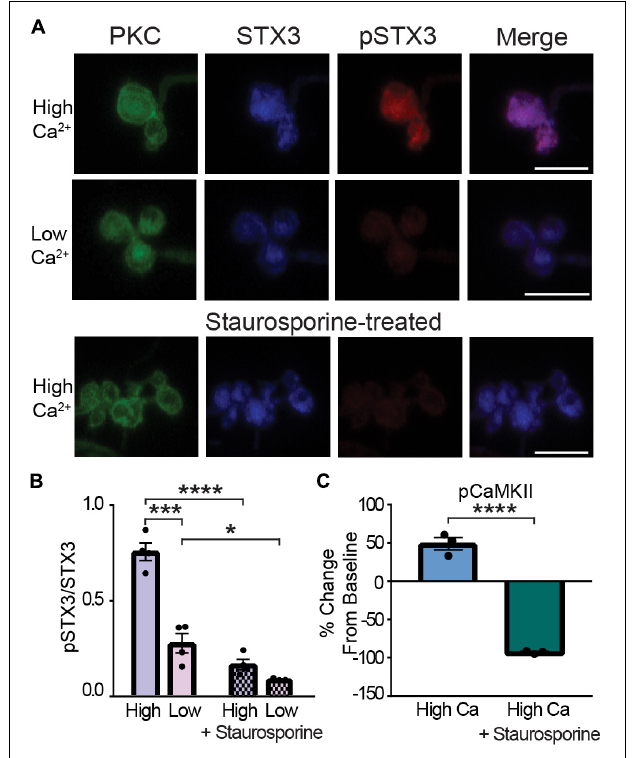
FIGURE 6 | Kinase inhibition prevents the Ca 2 + -dependent phosphorylation of STX3B at T14 in rod bipolar cell synaptic terminals. (A) Confocal images of synaptic terminals of isolated rod bipolar cells, identified by their characteristic morphology and PKC immunoreactivity (green), demonstrate an increase in pSTX3 immunoreactivity (red) under conditions of elevated intraterminal Ca 2 + (“High Ca 2 + ”) when compared to those incubated in a nominally 0 Ca 2 + external solution (“Low Ca 2 + ”). Treatment with staurosporine (100 nM; lower panel) blocked the expected Ca 2 + -evoked increase in pSTX3 immunoreactivity. Scale bar = 5 µ m. (B) Quantification of the pSTX3/STX3 ratio in rod bipolar cell terminals shows that elevated intraterminal Ca 2 + (“High”) significantly increased the pSTX3/STX3 ratio above that of cells bathed in external solution containing no added Ca 2 + (“Low”; p < 0.0001, n = 4,4 mice). Staurosporine not only blocked this Ca 2 + -evoked rise in the pSTX3/STX3 ratio ( p < 0.0001, n = 4,4 mice), it lowered the ratio of the low Ca 2 + control group ( p = 0.0366, n = 4,3 mice). (C) In parallel experiments, treatment with staurosporine suppressed the Ca 2 + -stimulated increase